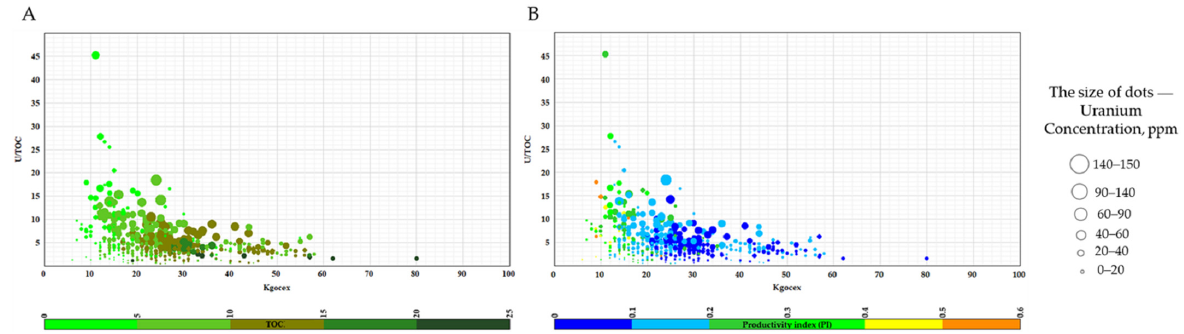
Figure 13. U/TOC – Kgoc ex diagram based on pyrolysis studies of 11 wells. The dot color corresponds to the total organic carbon TOC ( A ) and the productivity index PI ( B ), and the dot size reflects the uranium concentration.